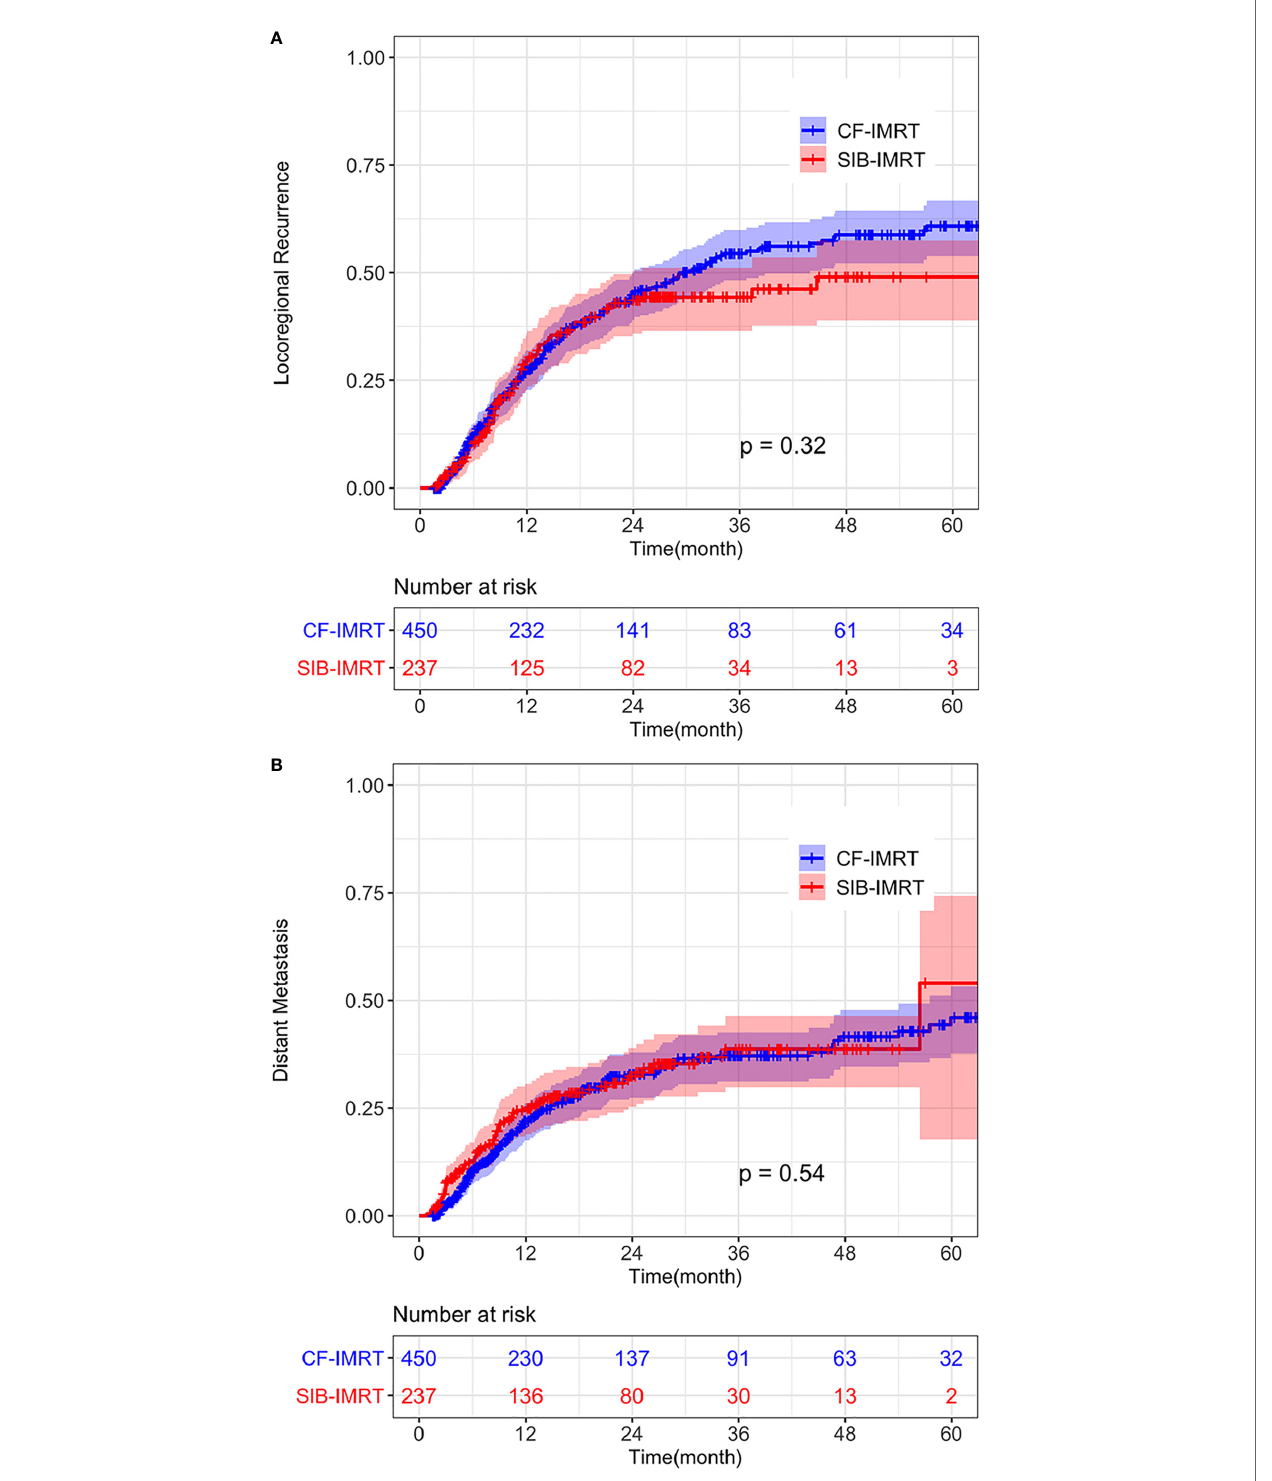
FIGURE 3 | Cumulative incidence of (A) Locoregional recurrence (LRR) and (B) distant metastasis (DM) of SIB-IMRT and CF-IMRT treated patients after PSM, with 95%